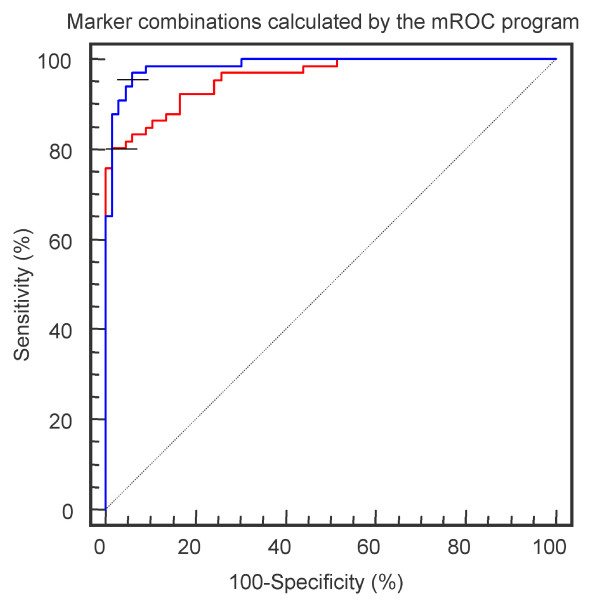
ROC curves for the best two-marker and three-marker combination calculated by the mROC program. The red line presents the ROC curve for the linear combination of MMP9 and TIMP1, the blue one the curve with the marker combination of MMP2, TIMP1, and MMP9. The equations of these virtual markers are given in Table 3.